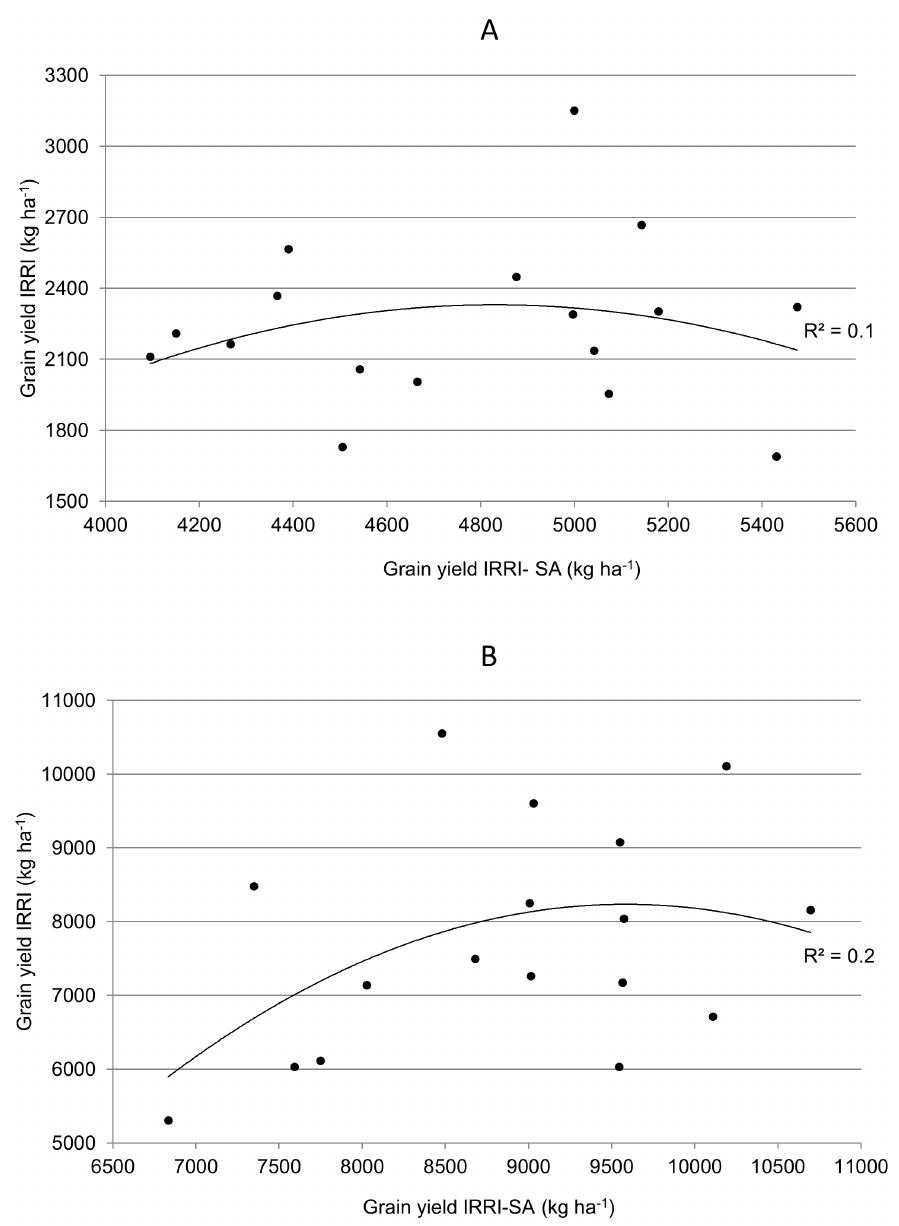
Figure 5. Correlation of GY performance of selected lines under drought stress and non-stress conditions in IRRI and IRRI-SA.